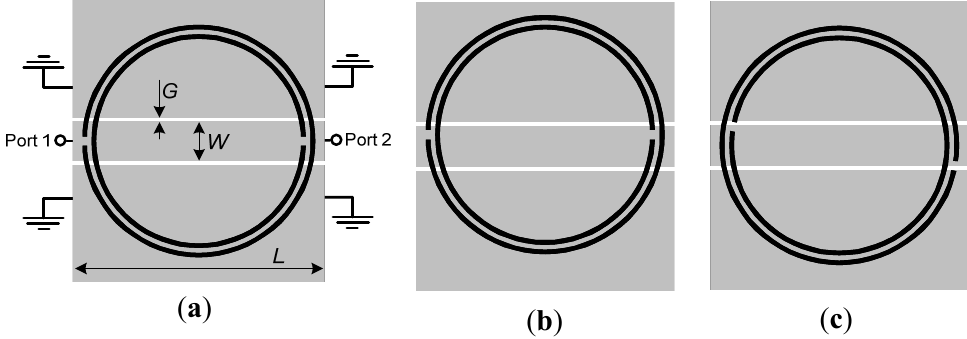
Figure 2. CPW loaded with a circular shaped SRR; ( a ) symmetrically placed; ( b ) displaced 0.5 mm; and ( c ) rotated 10°. Dimensions are: L = 10.4 mm, W = 1.67 mm, = 5 G = 0.2 mm, c = d = 0.2 mm and r ext